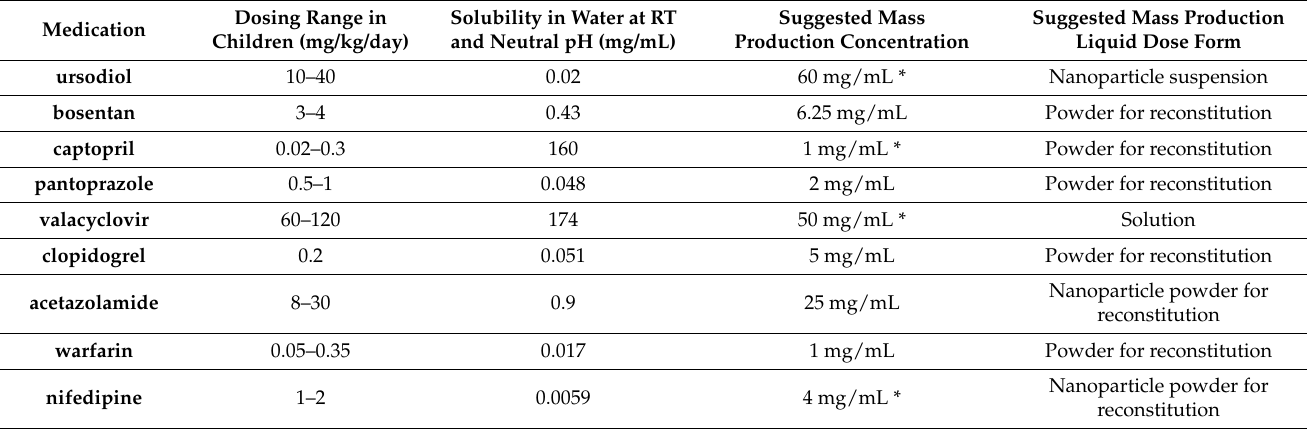
Table 4. Next-wave mass-manufactured API